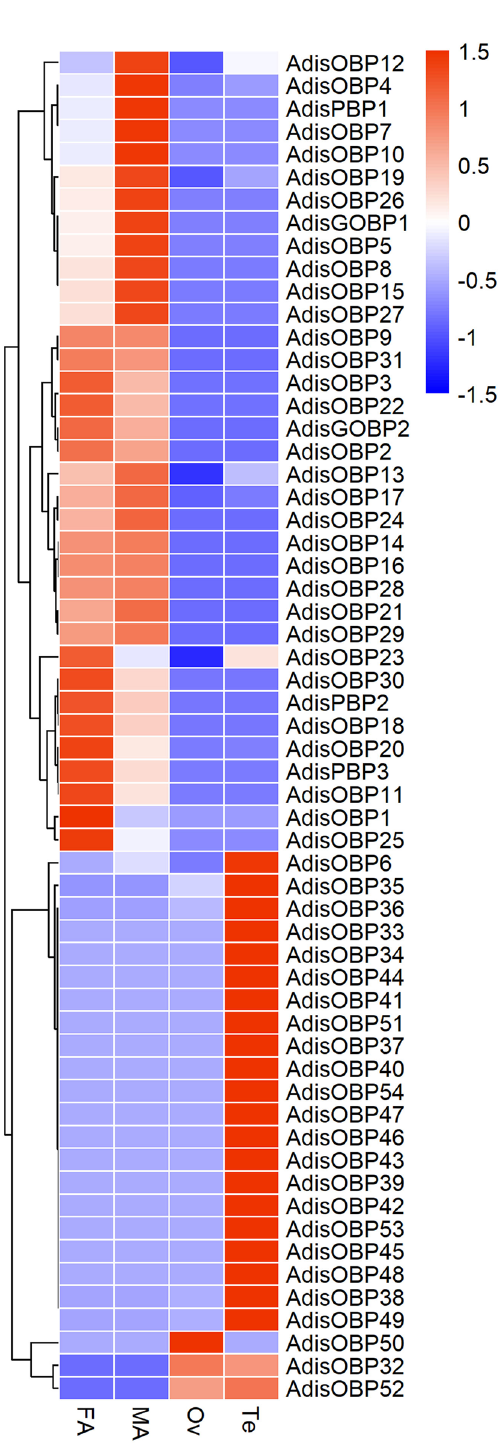
Figure 5. Heat map showing the abundance of unigenes encoding OBPs (including 5 OBPs identified in a previous study) in the Athetis dissimilis different tissues transcriptomes presented as normalized reads in reads per kilobase per million mapped reads (RPKM). In the figure each column represents 1 samples; each line represents 1 OBP gene. The color depth represents the number of reads contained in OBPs; red means more; blue means less. FA female antennae, MA male antennae, Ov ovaries, Te